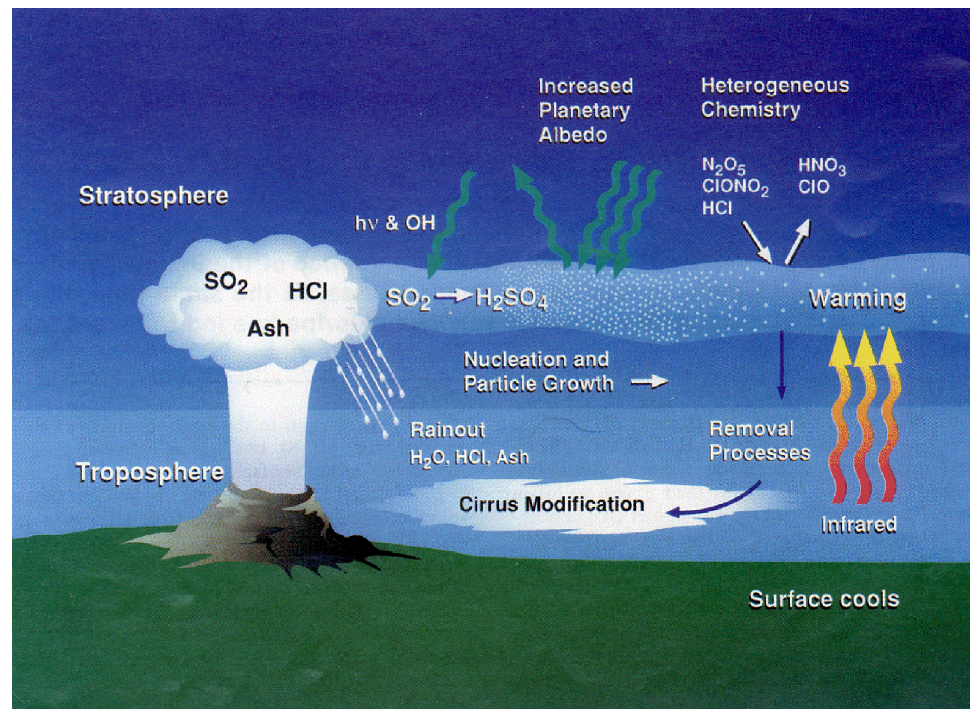
FIGURE 1. Schematic diagram showing the products injected into the atmosphere following an explosive volcanic eruption, chemical and physical processes that may occur and the potential climatic response. See text for details. (After McCormick, M.P., Thomason, L.W., and Trepte, C.R. Atmospheric effects of the Mt. Pinatubo eruption. Nature 373 , 399(cid:150)404, 1995.) With permission from Nature